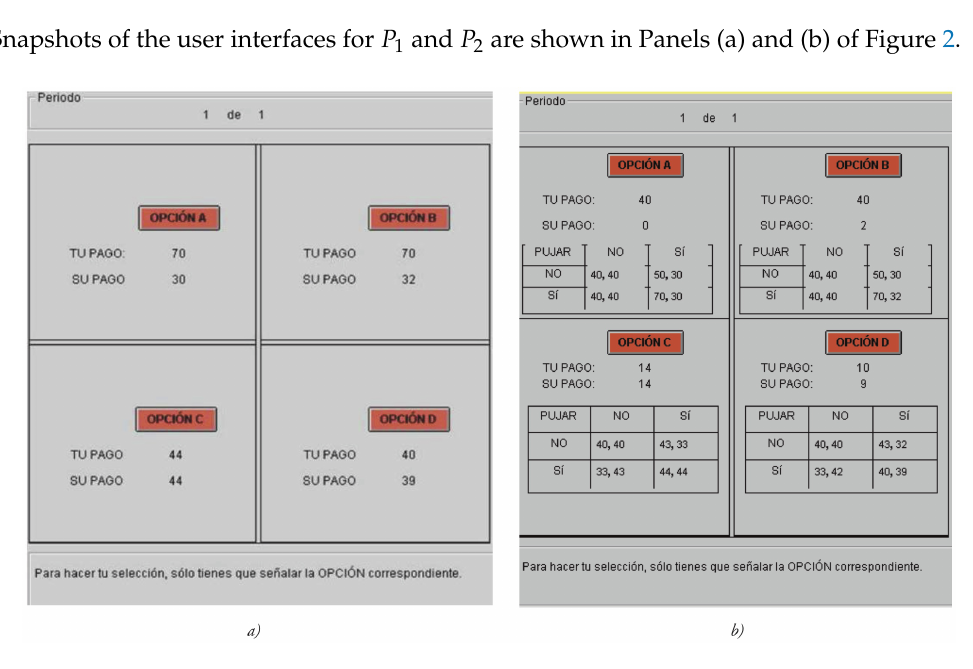
Figure 2. User interface for the distributional decisions of ( a ) P 1 and ( b ) P 2